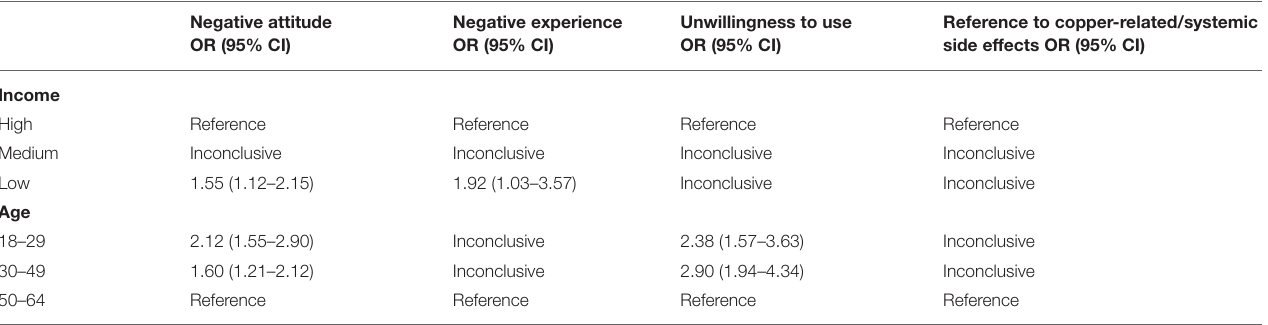
TABLE 4 | Associations between sociodemographic characteristics and negative attitudes toward, negative experience of, unwillingness to use or having made reference to copper-related or systemic side effects of the copper IUD, expressed as odds ratios (ORs) with 95% confidence intervals (CIs).